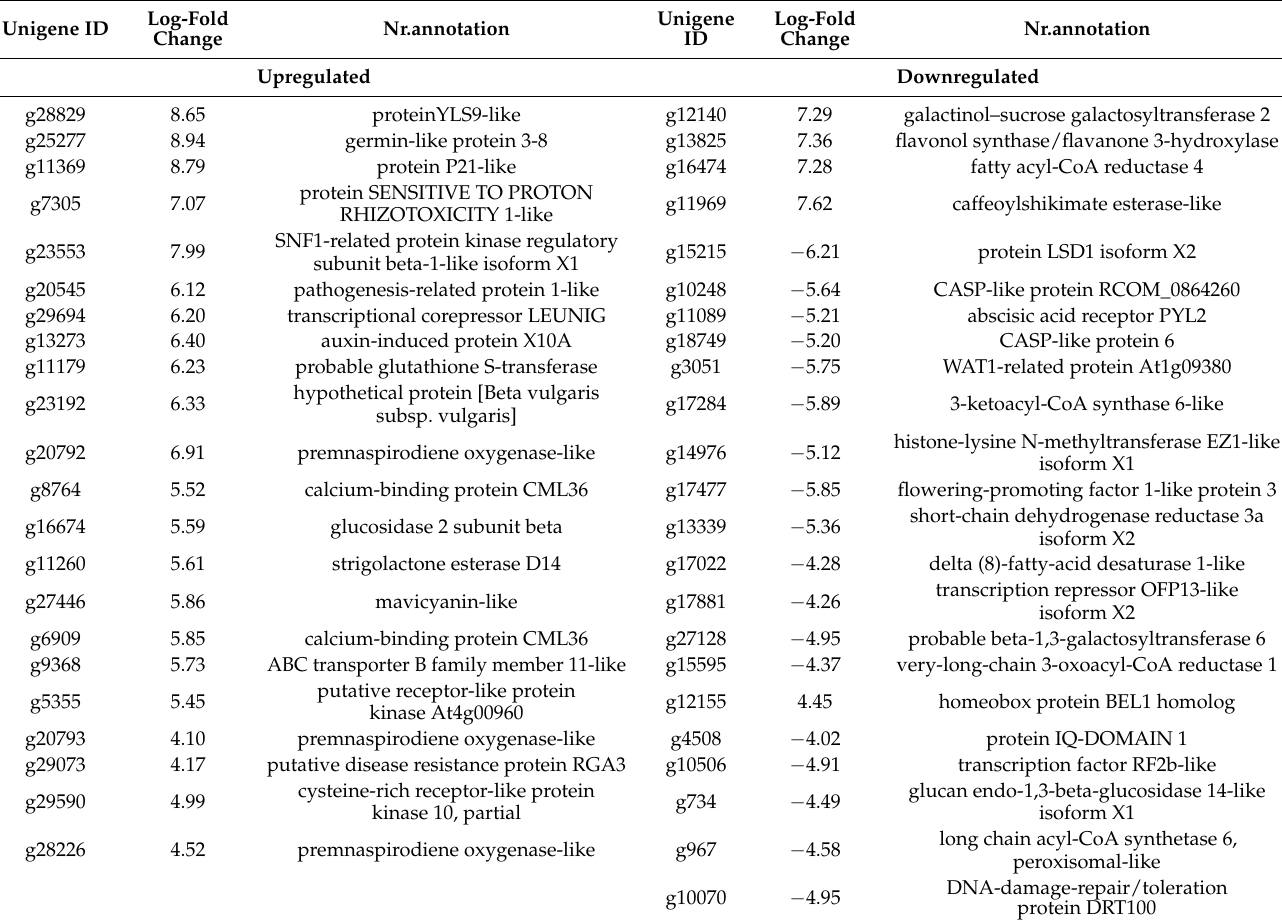
Table 2. Differentially expressed genes (DEGs) in date palm leaf tissues under UV-B